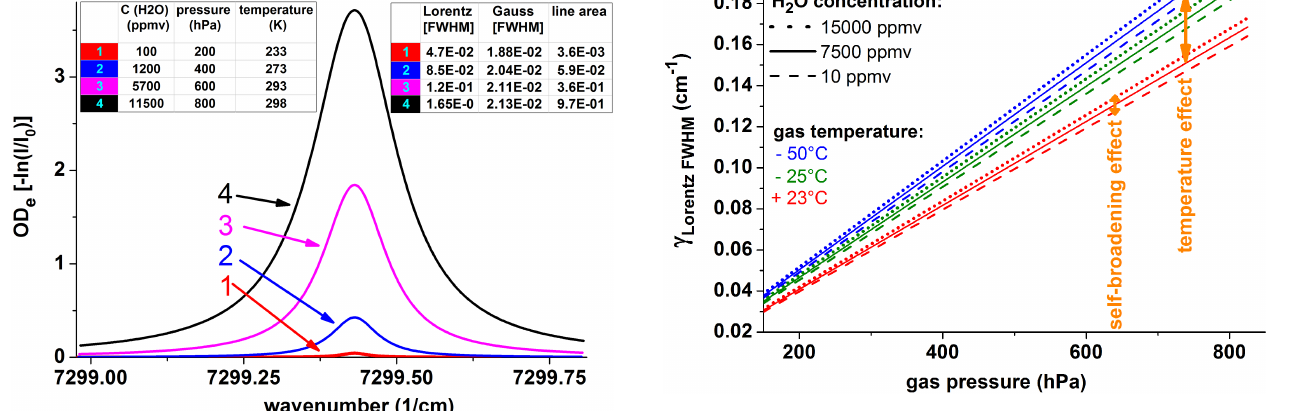
Figure 4. Simulated atmospheric H 2 O absorption profiles at pos- itions 1 to 4 in Fig. 3 illustrating the effect of (see text for details) temperature and foreign- and self-broadening on the used water transition (1370nm) for a typical vertical atmospheric height pro- file. Parameter sets ( T , p , C ) of the individual lines and the resulting line widths are also shown. All line shapes are based on the same Voigt profile approximation, which is also used to pursue the fitting process.